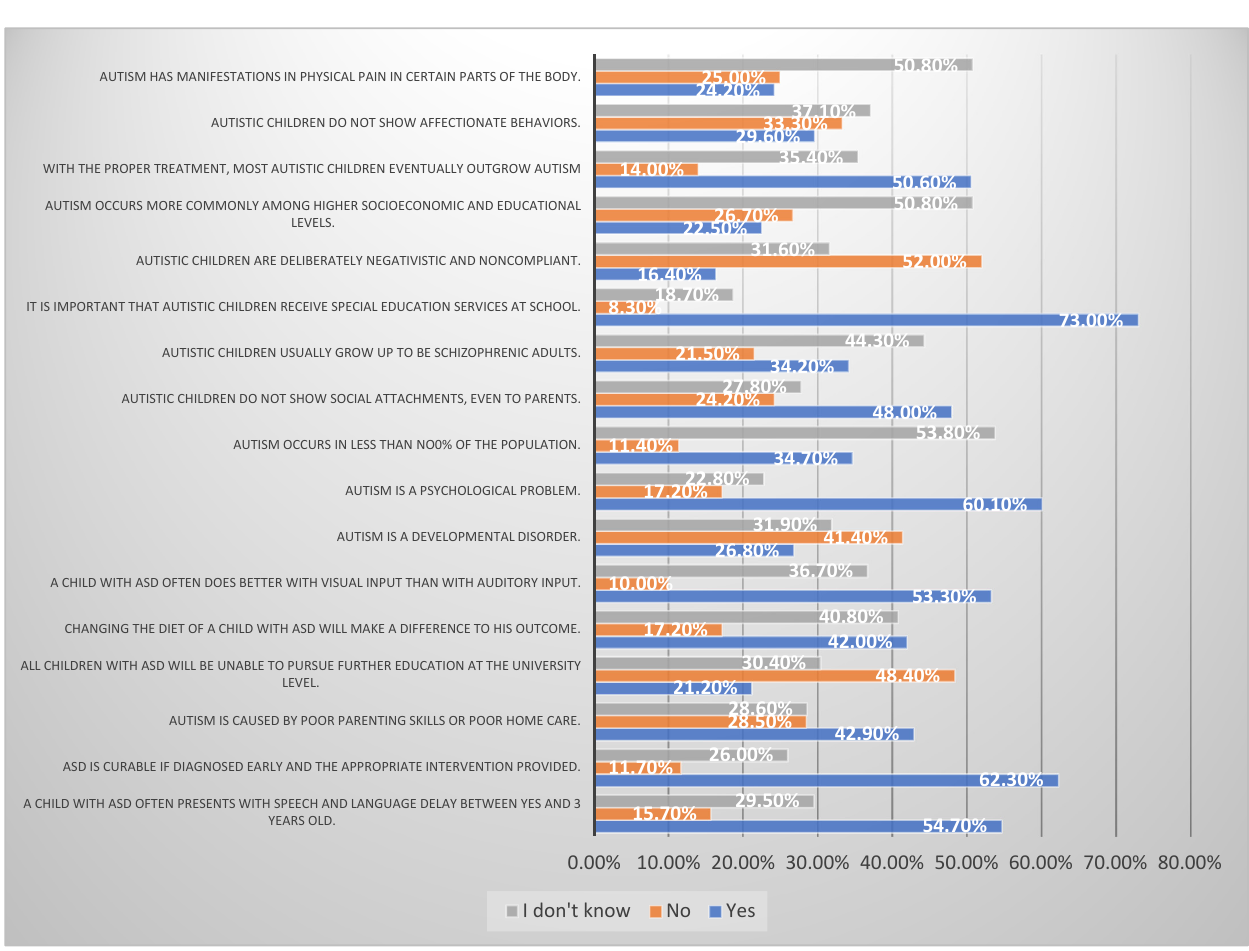
Table 3. Binary logistic regression analysis.